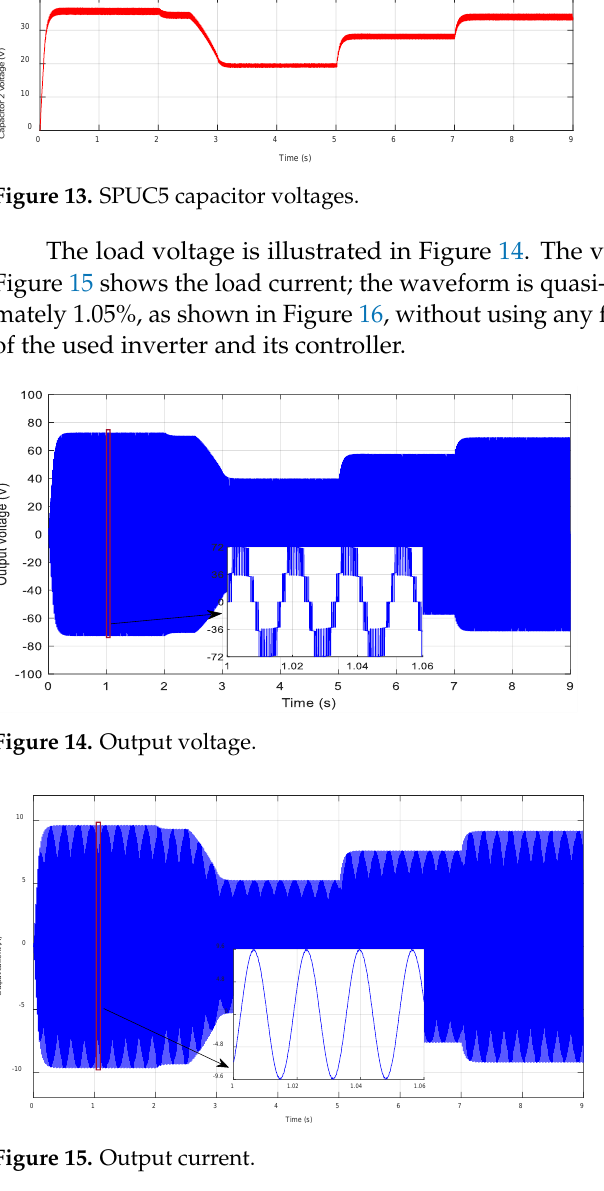
Figure 15. Output Figure 15. Output current. Figure 15. Output current.